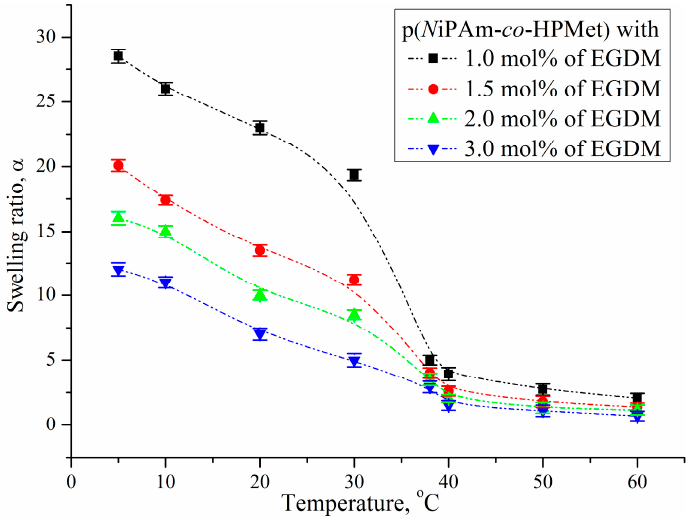
Figure 2. Change in the swelling ratio, α , of p( N iPAm- co -HPMet) depending on temperature. Error bars represent the standard deviation of three replicates. bars represent the standard deviation of three